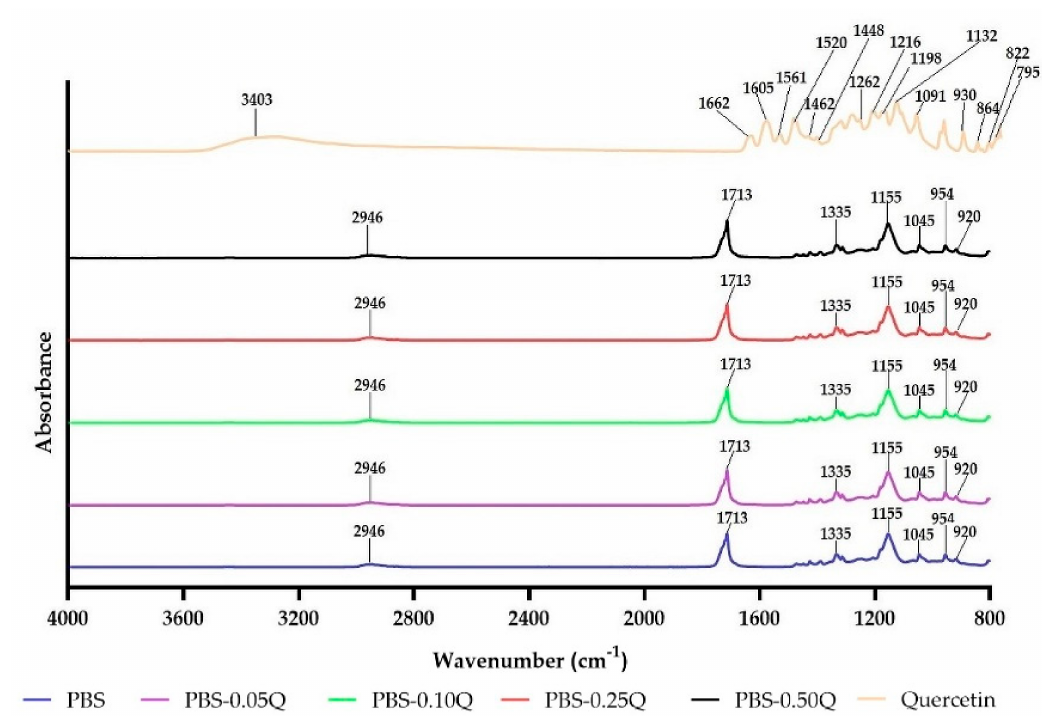
Figure 5. Fourier-transform infrared (FT-IR) spectra of PBS-based films.